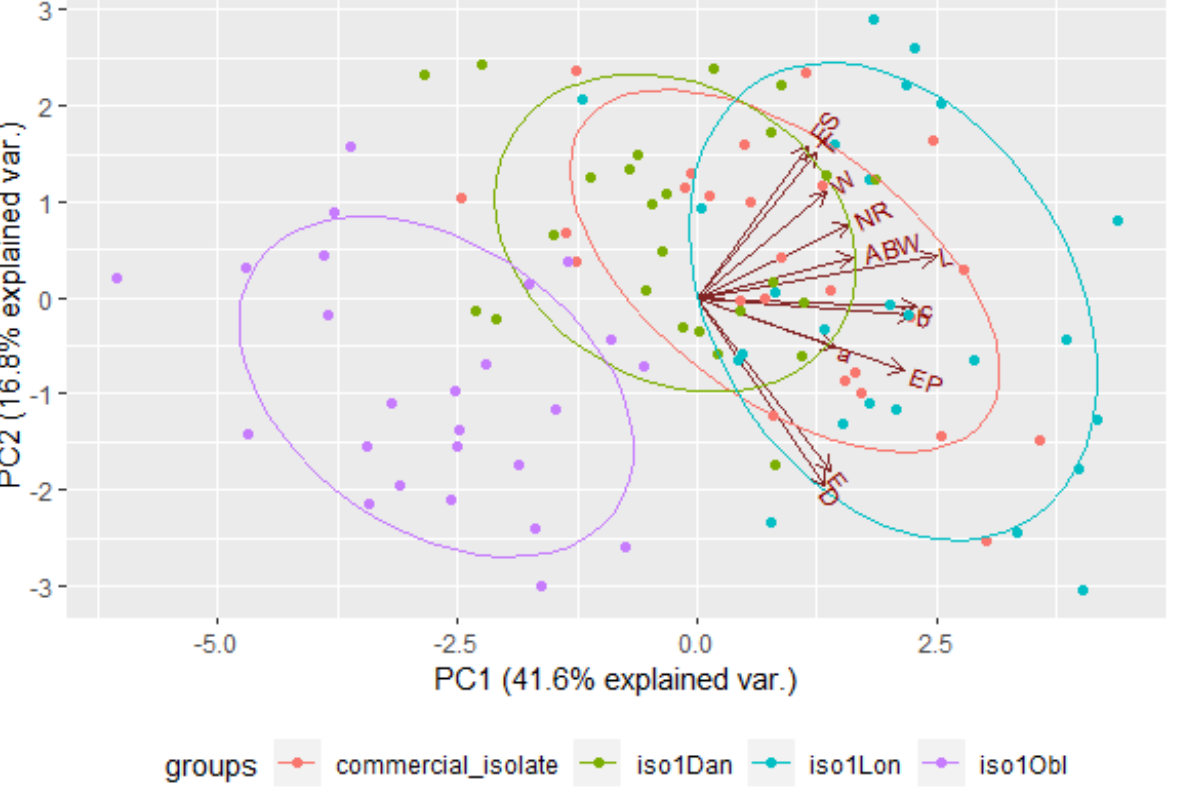
Figure 5. Principal component analysis for infective juveniles—individuals.